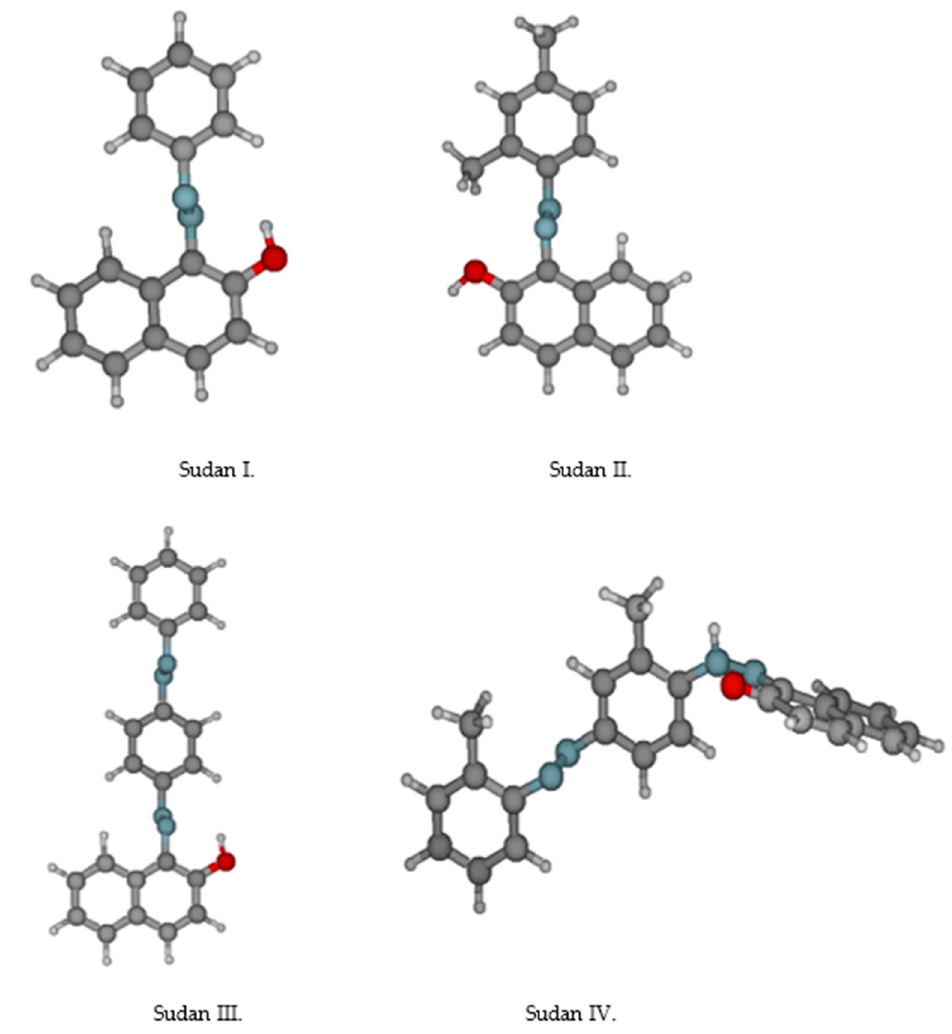
Figure 16. Ball and stick atomic model of Sudan.